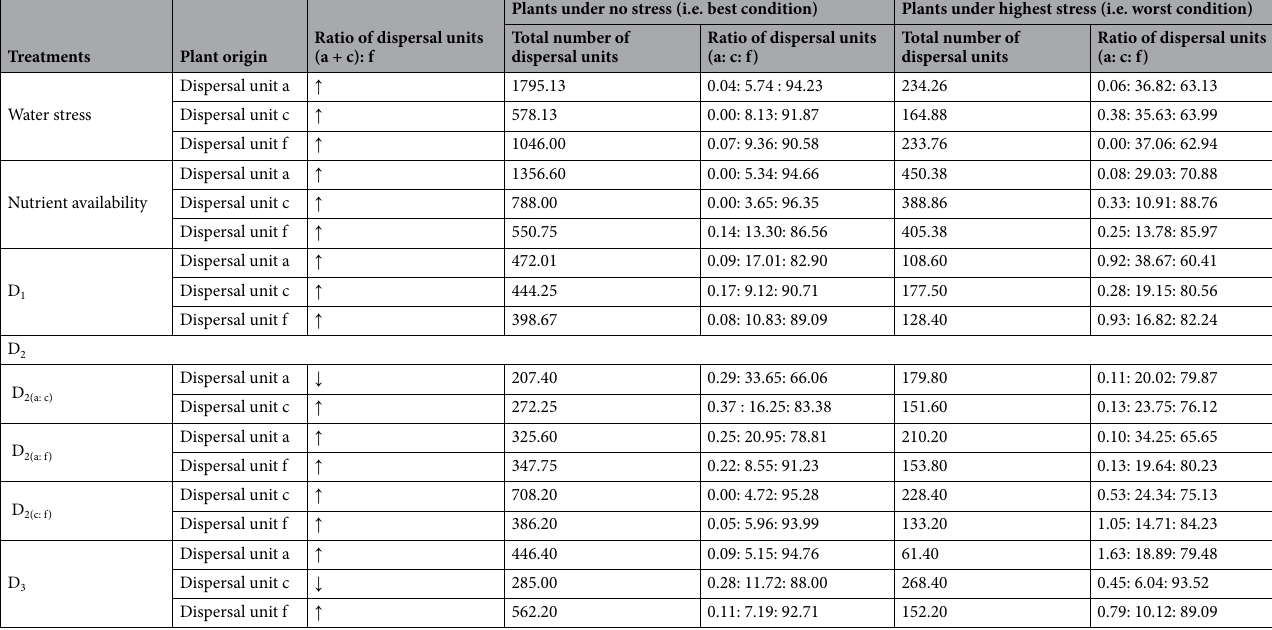
Table 3. Variation in the ratio of dispersal unit morphs a, c and f of Ceratocarpus arenarius plants derived from each dispersal unit morph grown under nonstressful and stressful conditions. Ratio of dispersal unit (a + c): f increased ( ↑ ), decreased ( ↓